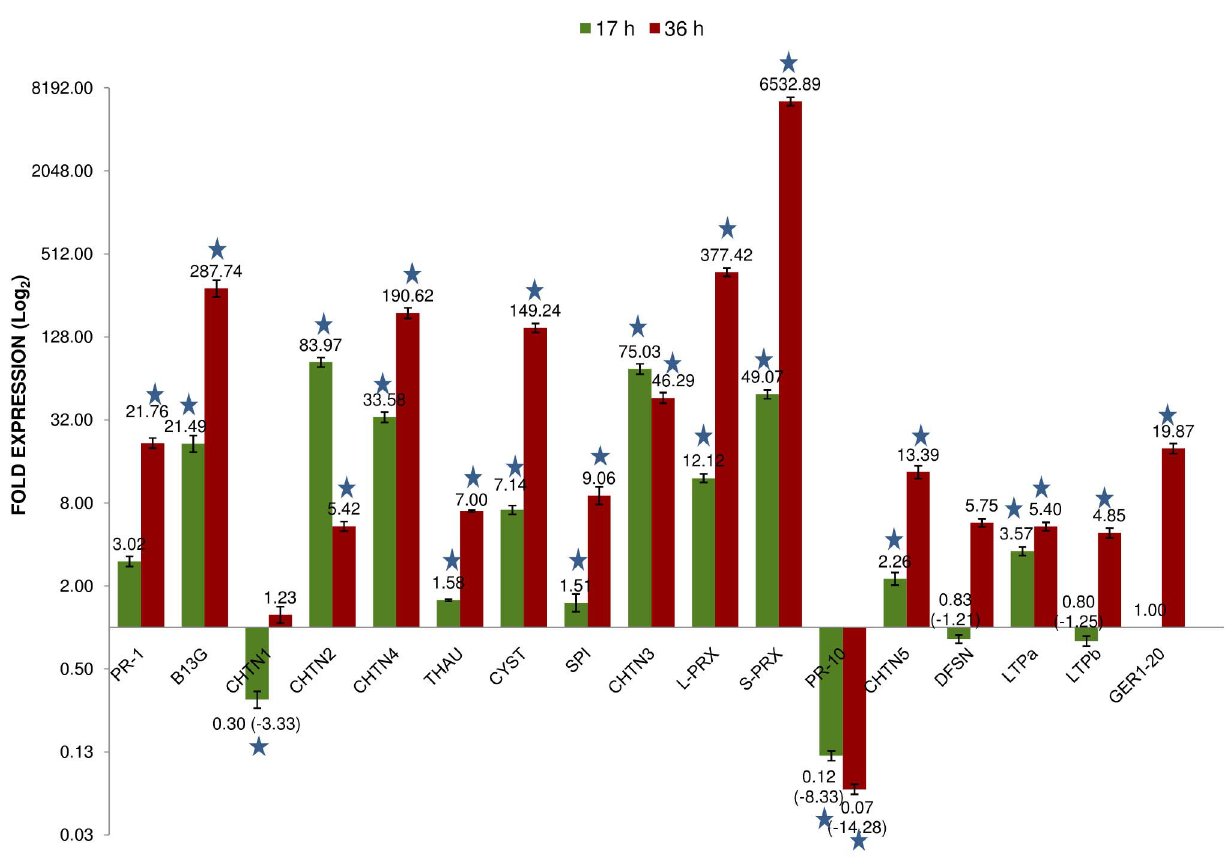
Figure 5. Expression profiling of Pathogenesis-related gene families in W.somnifera . Results are mean of triplicate data from independent replications and the error bars represent standard deviation. The gene IDs are given in Table-2 and the number on each bar represent relative fold expression. Asterisk indicate statistical significance of P , 0.01. 17 h= Expression of PR genes in 17 hours post SA treated leaf tissues; 36 h= Expression of PR genes in 36 hours post SA treated leaf tissues.